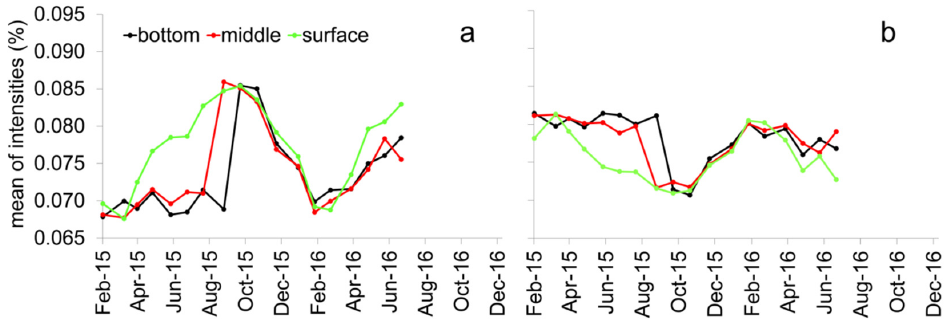
Figure 4. Distribution of the product group and degraded group with highly positive correlation between MF and PARAFAC component 1 ( a ) and 2 ( b ).